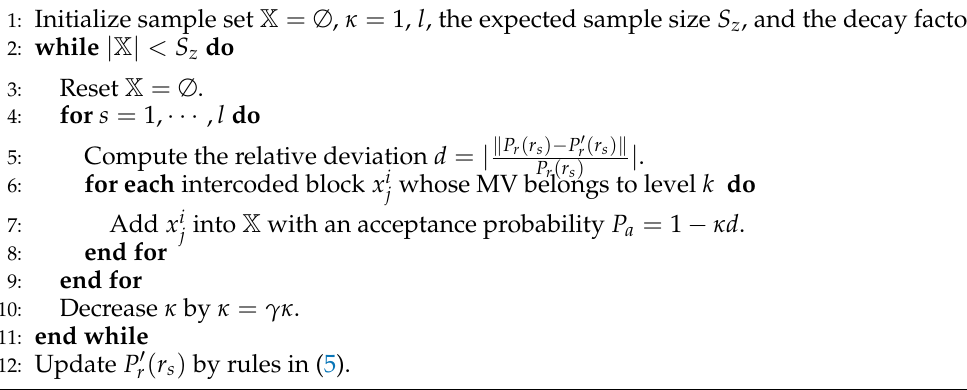
Algorithm 1 Sampling block filter algorithm